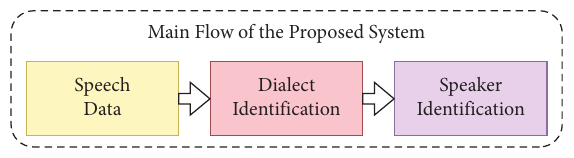
Figure 4: Main flow of the proposed